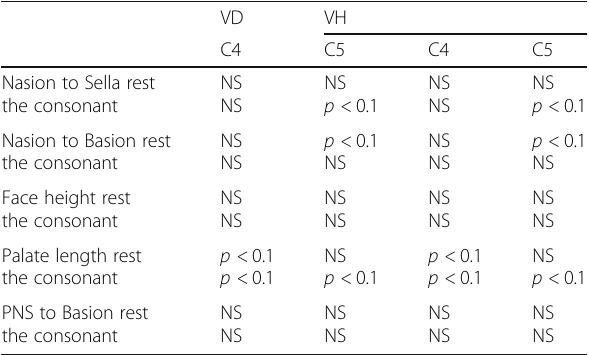
Fig. 8 Comparison of the range of incisor and molar bracket-derived artifact between two magnetic resonance imaging sequences